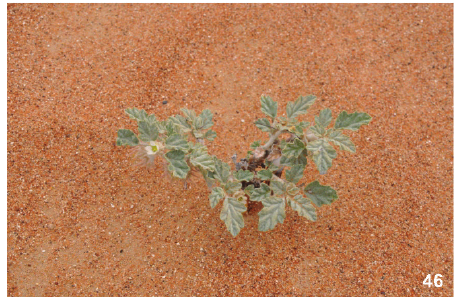
Figure 46. Neuradaceae: Neurada procumbens